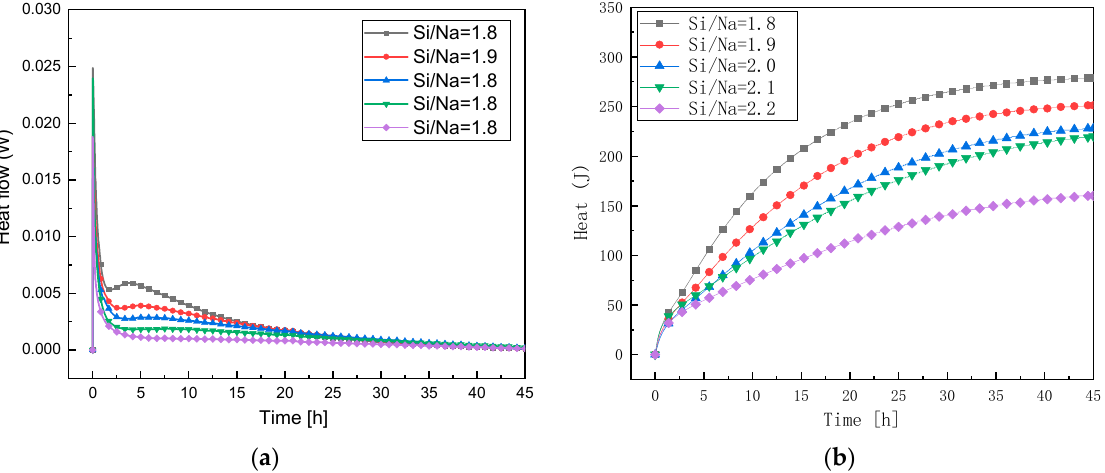
Figure 7. ( a ) The exothermic reaction rates at different Si/Na ratios; ( b ) the total exothermic reaction map at different Si/Na ratios.